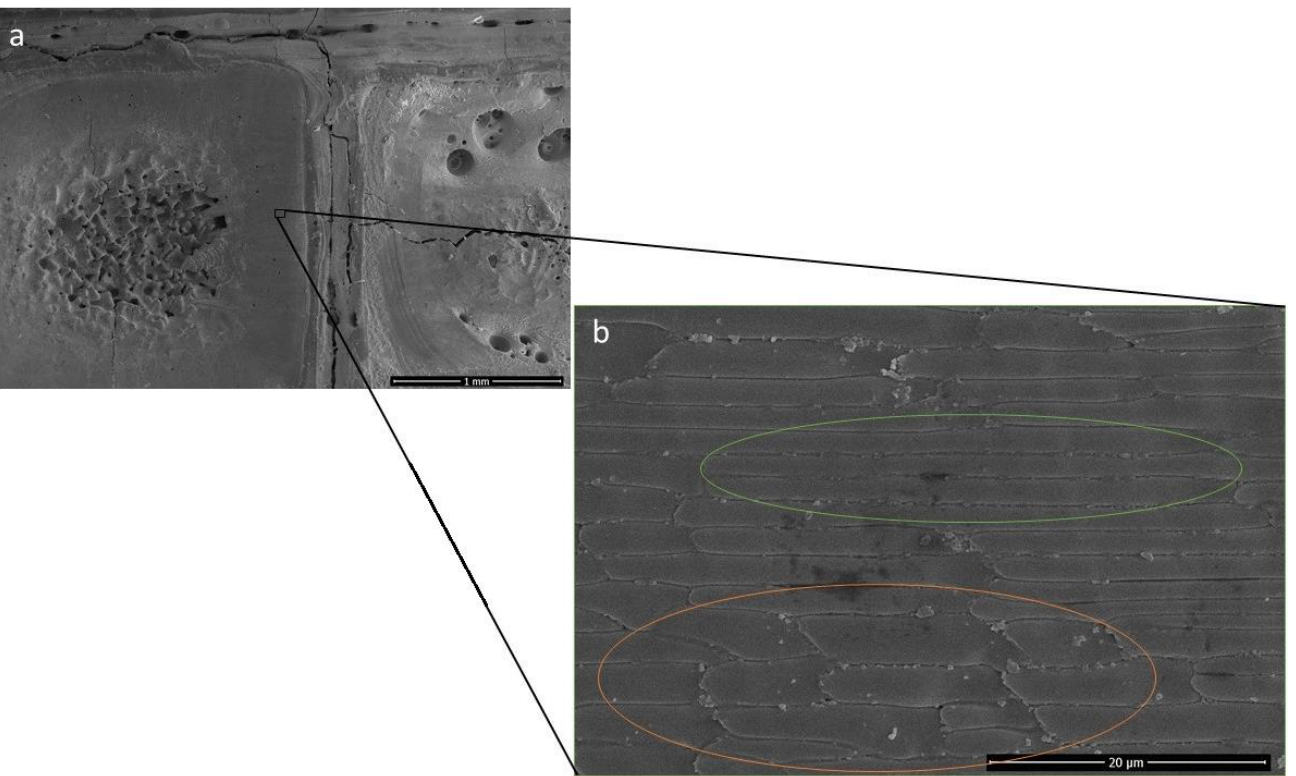
Figure 5. ( a ) Al 2 O 3 wt % 90, SiC wt % 10 at 160 W laser power. ( b ) Inhibitory effect of grains